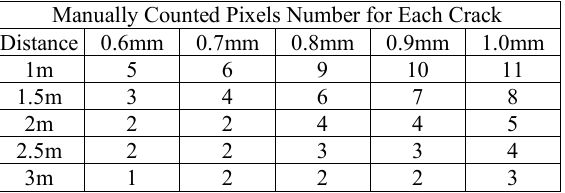
Table 5. The number of manually counted pixels.